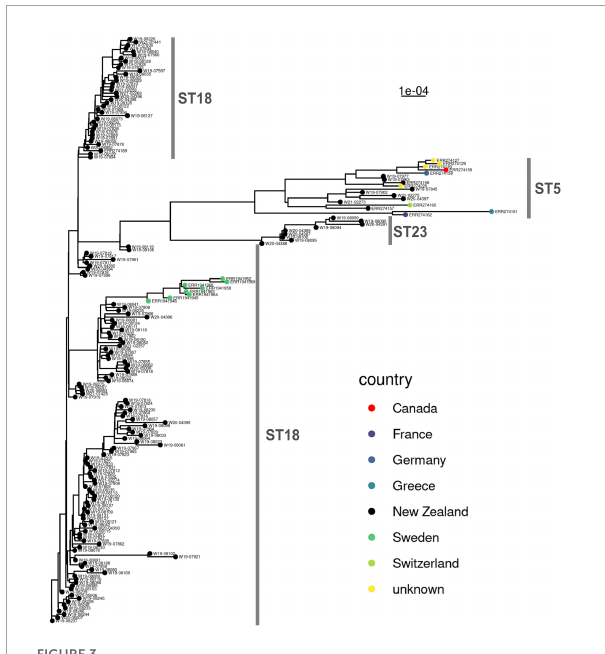
FIGURE3 Maximum-likelihood phylogenetic analysis comparing n = 163 New Zealand and n = 20 international genomes of Paenibacillus larvae . The scale bar shows the genetic distance. The multilocus sequence types are delineated in gray, alongside the phylogenetic